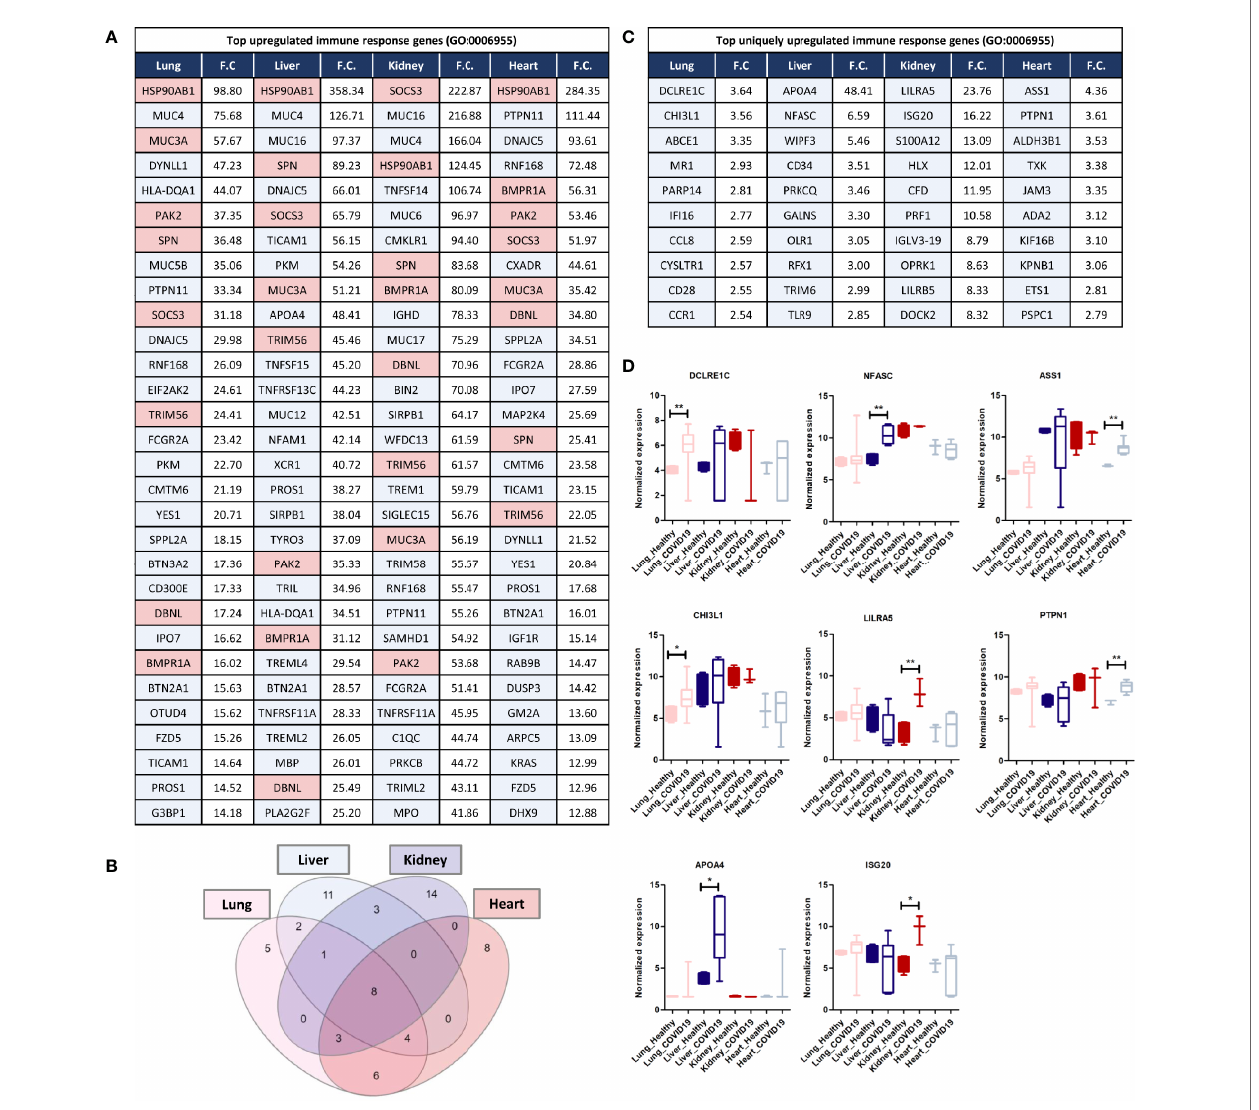
FIGURE 5 | (A) Top 30 upregulated immune response genes in lung, liver, kidney, and heart tissues in response to SARS-CoV-2 infection; F.C.: fold change; light red represents commonly upregulated genes within the top 20 genes across the 4 types of tissues. (B) Venn diagram representation of the overlap between the top 20 upregulated immune response genes in each tissue, enlisted in (A) . (C, D) Top Immune response genes uniquely upregulated in lung, liver, kidney, and heart tissues in response to SARS-CoV-2 infection. * represents p-value < 0.05; ** represents p-value < 0.01 analyzed using T-test statistical